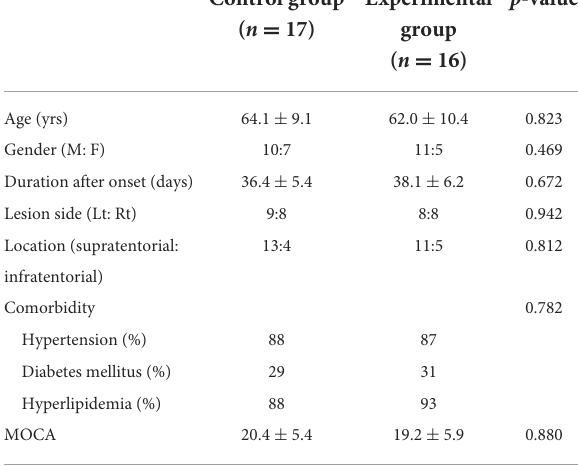
TABLE 1 Baseline